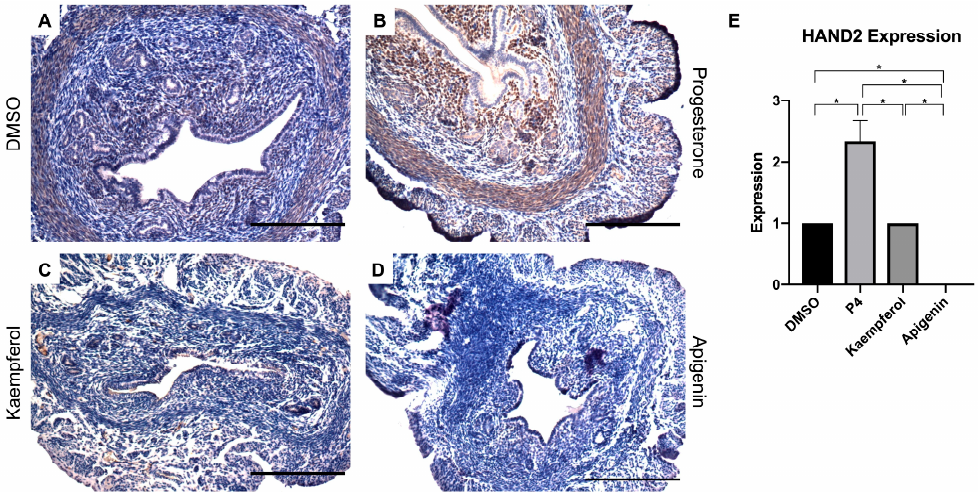
Figure 1. Kaempferol and apigenin did not increase HAND2 expression in mouse uteri. Immunohistochemical staining against progesterone receptor target HAND2 on uterine cross sections of control- ( A ), progesterone- ( B ), kaempferol- ( C , D ) apigenin-treated mice. Scale bar = 100 µ m; magnification 20×. ( E ) Quantification of HAND2 expression per treatment in representative images. One-way ANOVA test was used to determine significance (* p < 0.05).